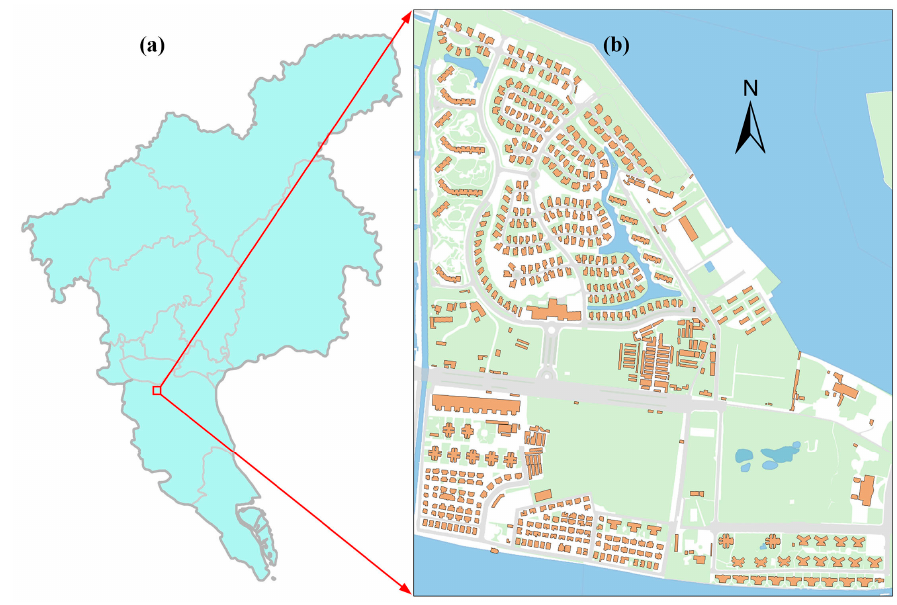
Figure 5. Experimental region and dataset: ( a ) Guangzhou region, and ( b ) the experimental dataset.